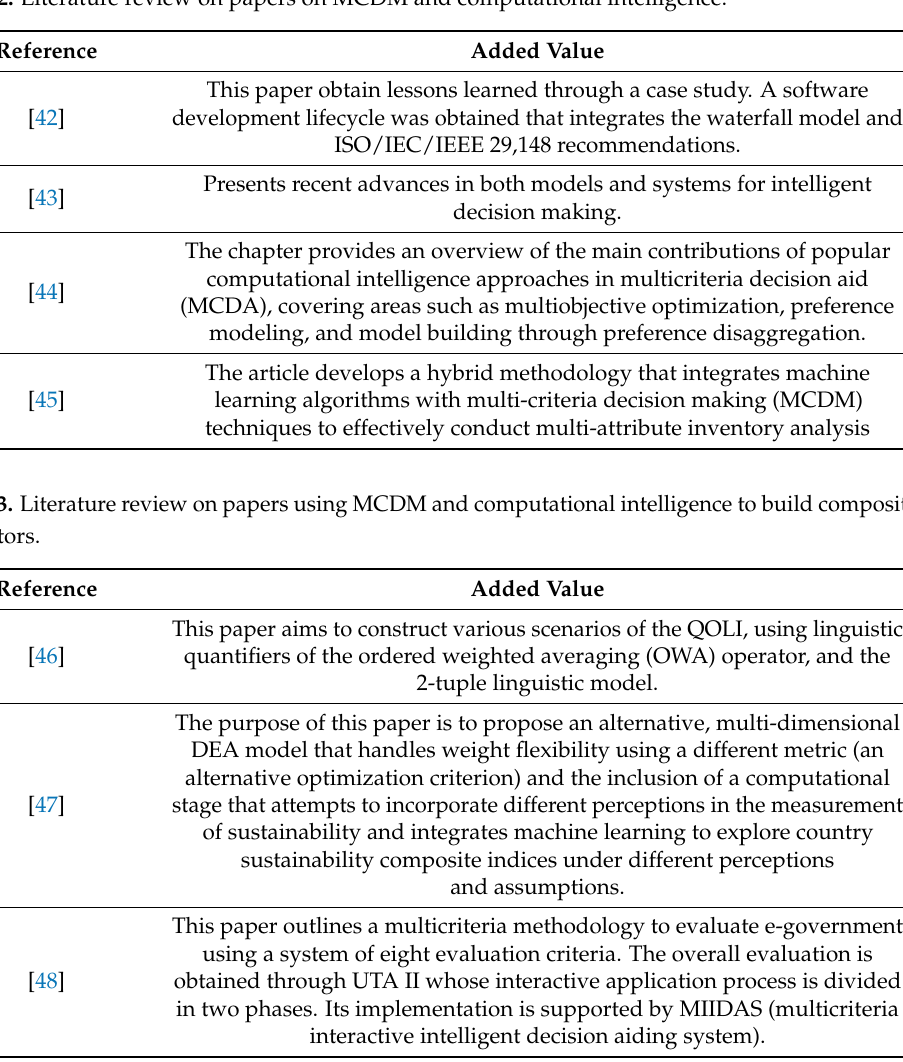
Table 2. Literature review on papers on MCDM and computational intelligence.